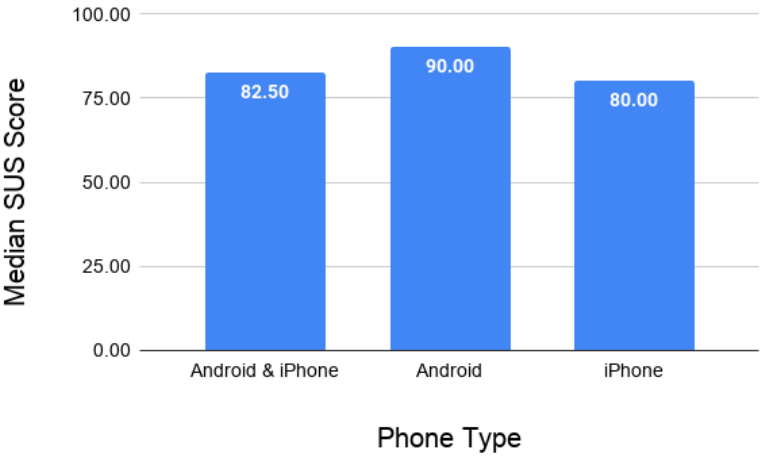
Figure 10. Median SUS scores by phone type for the second design iteration of Mission